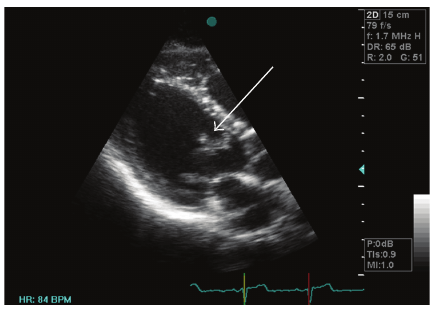
Figure 1: Evidence of strand-like LV masses, as shown by TTE.